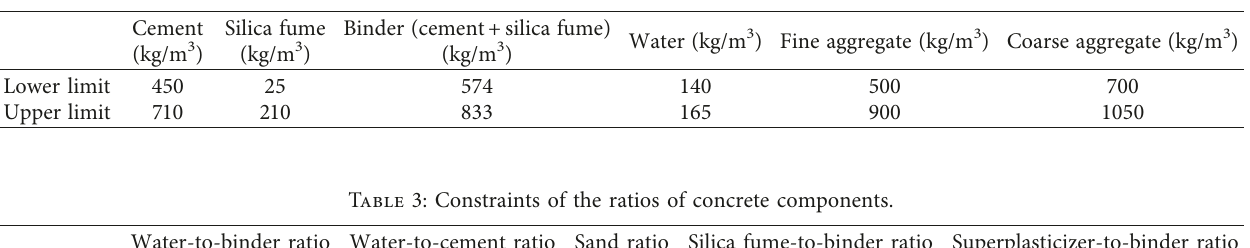
Table 2: Constraints of the contents of concrete components.